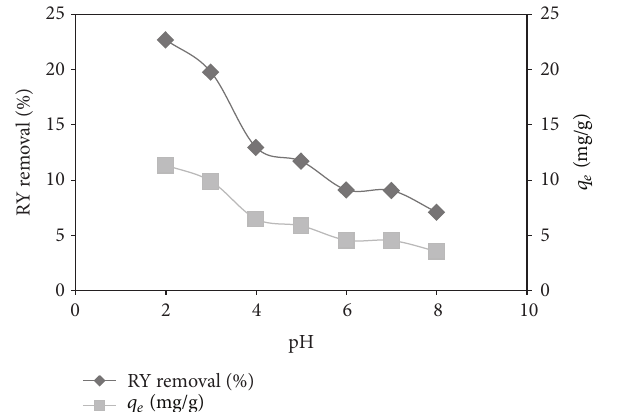
Figure 5: The initial dye concentration effect on adsorption of Remazol Yellow for 𝐴 = 0.1 g/50mL and 𝐵 = 0.4 g/50 mL adsorbent dosages (contact time: 60 min, temperature: 293K, pH: